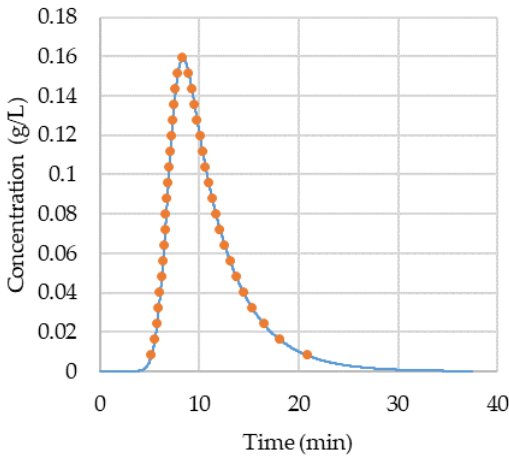
Figure 3. Scheme of the data point selection. The blue curve is the original concentration curve. The orange dots are the points, at which the time is taken as data point for the dataset. The first point starts at the maximum. The following points are left and right of the maximum at 95%, 90%, descending in 5% steps until 5% of the maximum concentration is reached.